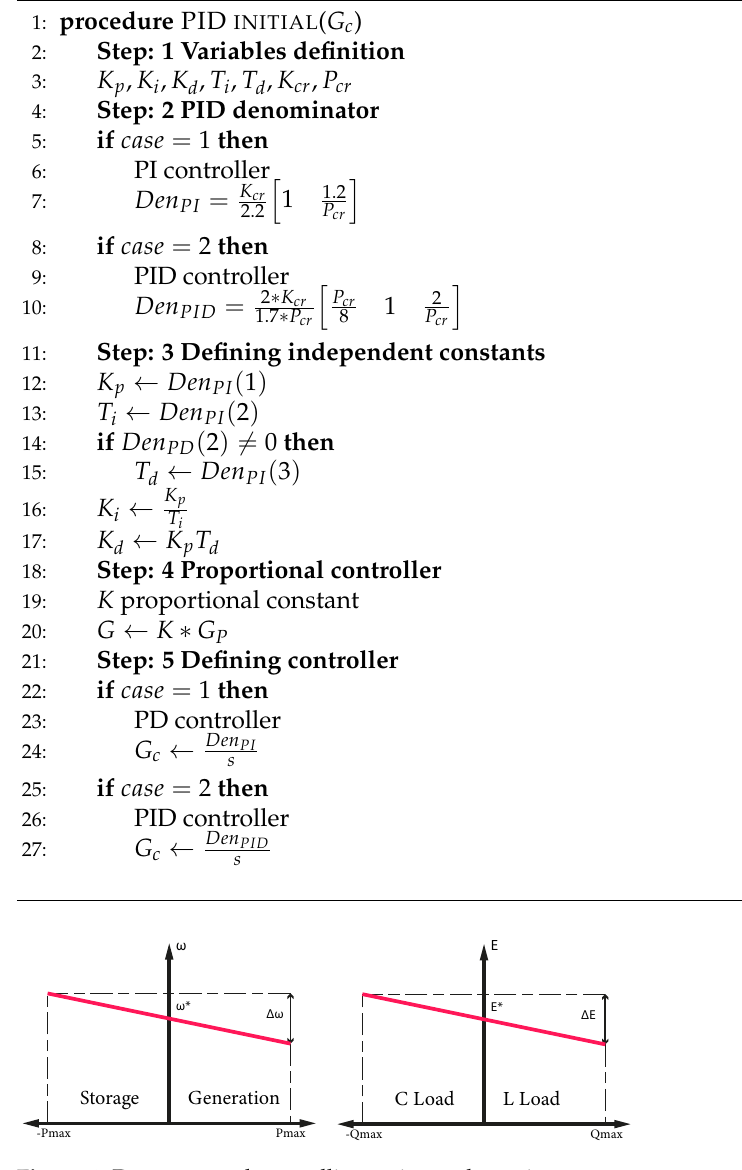
Algorithm 2 PID initial coefficient using ZN tuning.